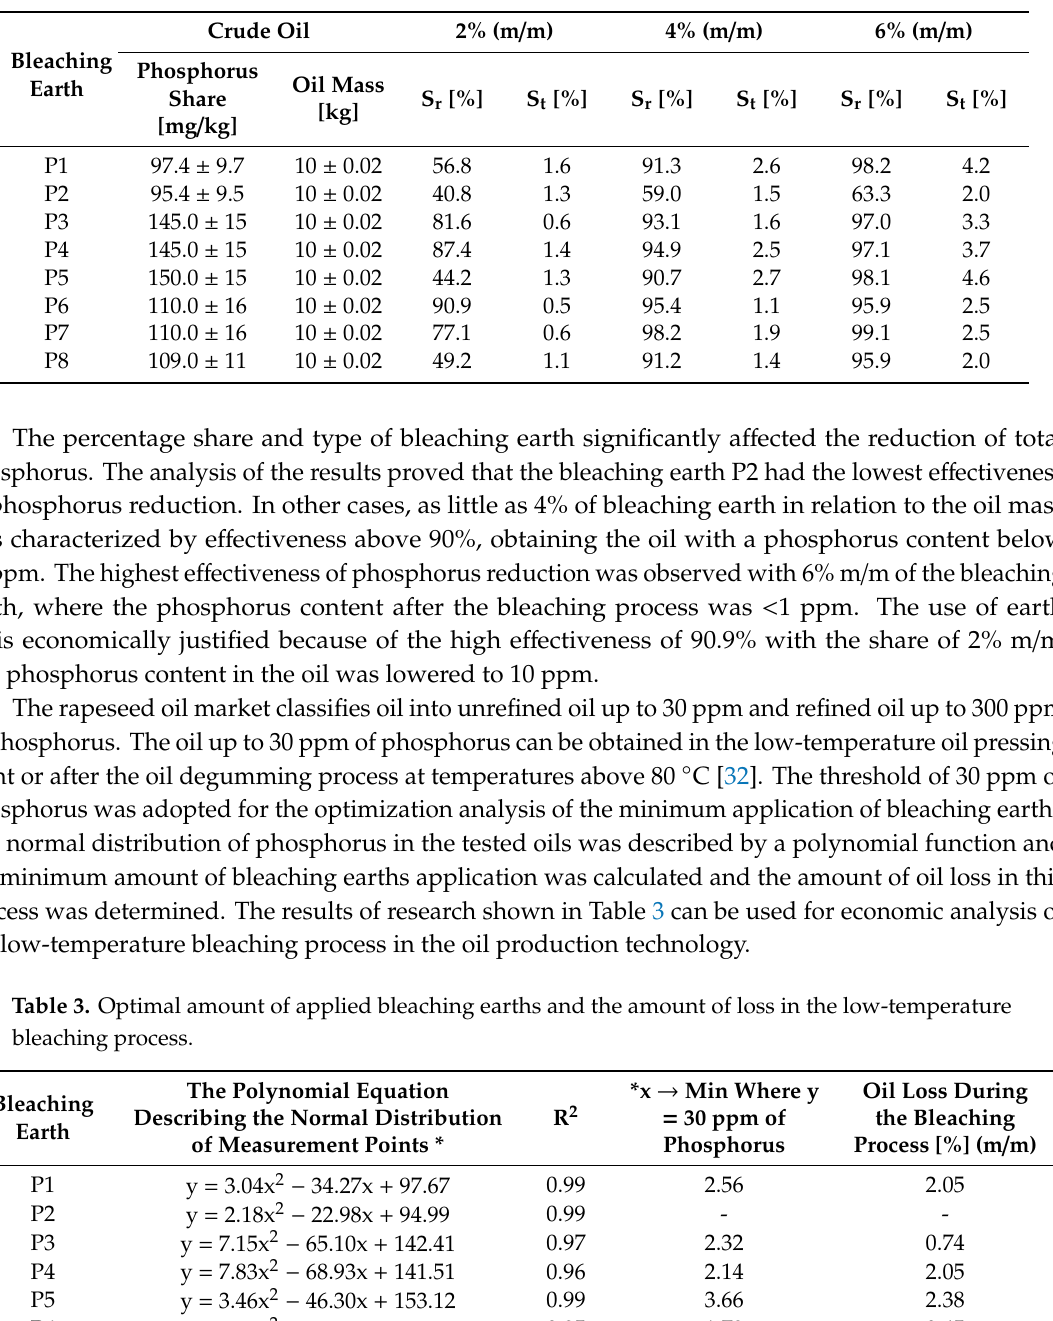
Table 2. Results of e ff ectiveness of reduction phosphorus and oil loss in the bleaching process.